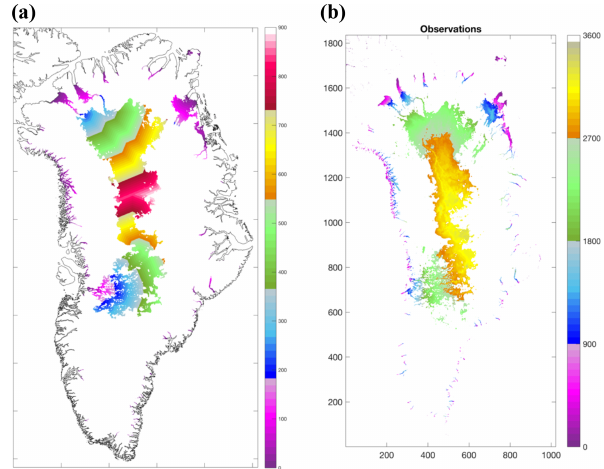
Figure D3. (a) Distance from the ocean for all ice sheet points iden- tified as in potential contact with the ocean. (b) Ice thickness of all points connected to the